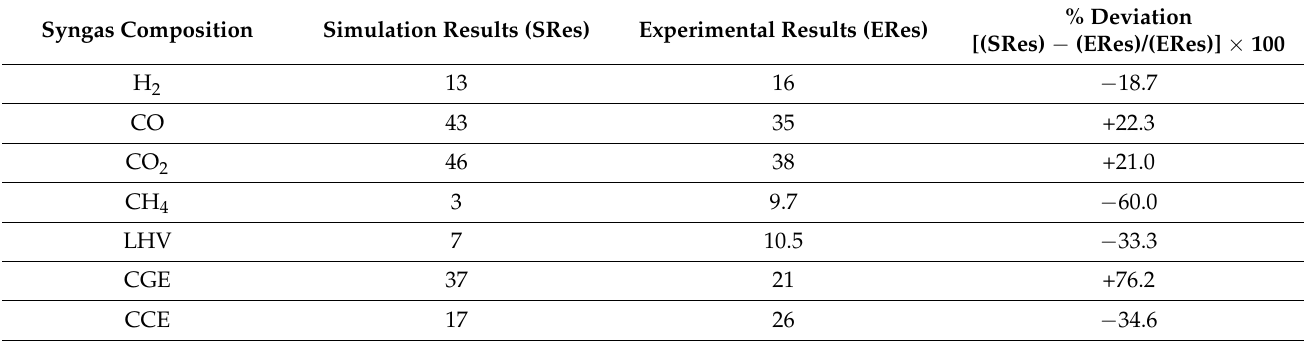
Table 7. Deviation between the simulated (SRes) with experimental results (ERes) at 900 ◦ C with ER = 0.3 (air gasification) Syngas Composition Simulation Results (SRes) Experimental Results (ERes)